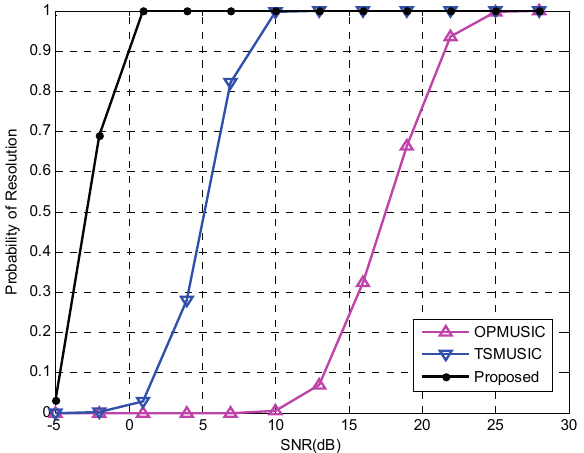
Figure 4. Probability of resolution (PR) versus signal-to-noise ratio (SNR). 500 independent trials are realized for each of the three